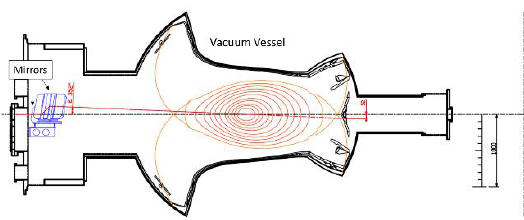
Fig. 2. Cross-sectional view inside the LHD 9-O port vacuum vessel, with two mirrors to focus the beam at the plasma center; the distance from M1 to the plasma center is around 2.5 m. The EC waves are detected at an angle of 2.3 degrees, with the line of sight looking slightly upward from the horizontal plane.